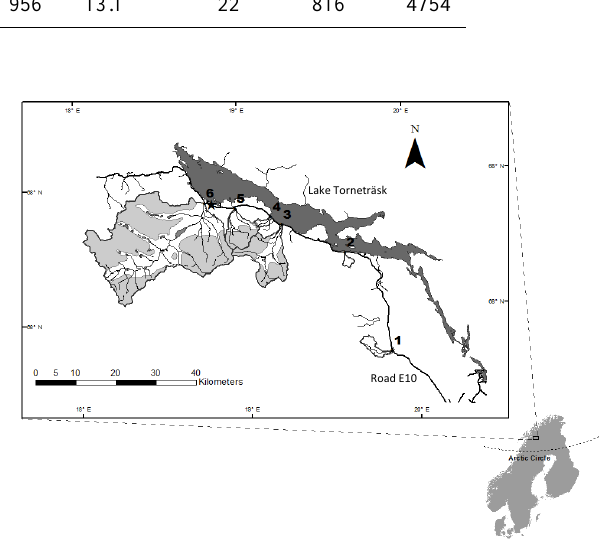
Fig. 1. The six catchments studied in the Abisko region. The grey areas are those above 880m where mountain permafrost can occur more